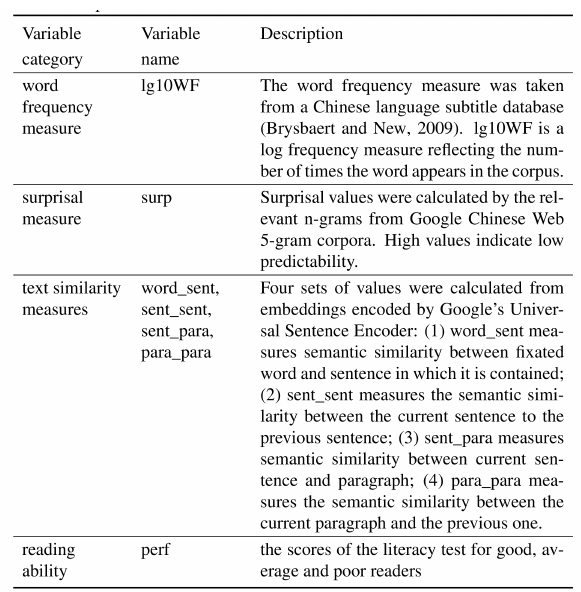
Table 1. Description of the fixed-effect independent variable